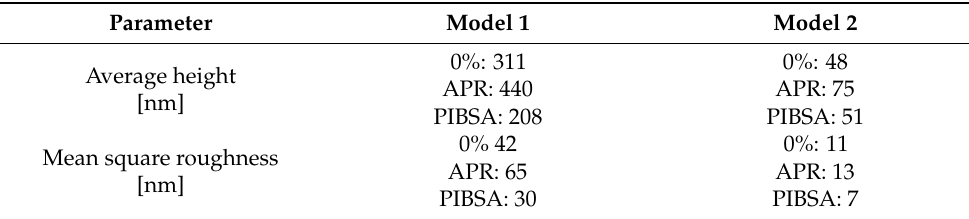
Figure 5. Height as a function of the projected length and morphology of aggregates/sediment of an undisturbed asphaltenes in toluene solution. The green icons are the experimental points, the dashed line is for illustrative purposes only and the image is to show the area where data was extracted. Table 5. Average height and the mean square roughness for model 1 and model 2 after addition of the inhibitors/dispersants APR and PIBSA and 0% of additive for